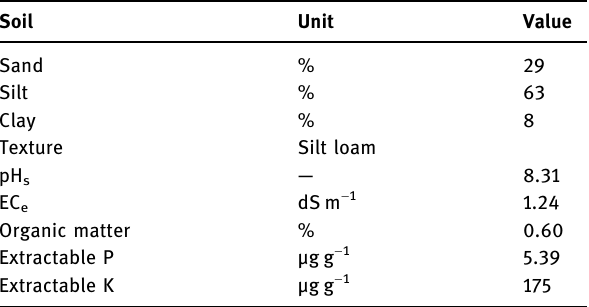
Table 1: Pre - experimental characteristics of the soil Soil